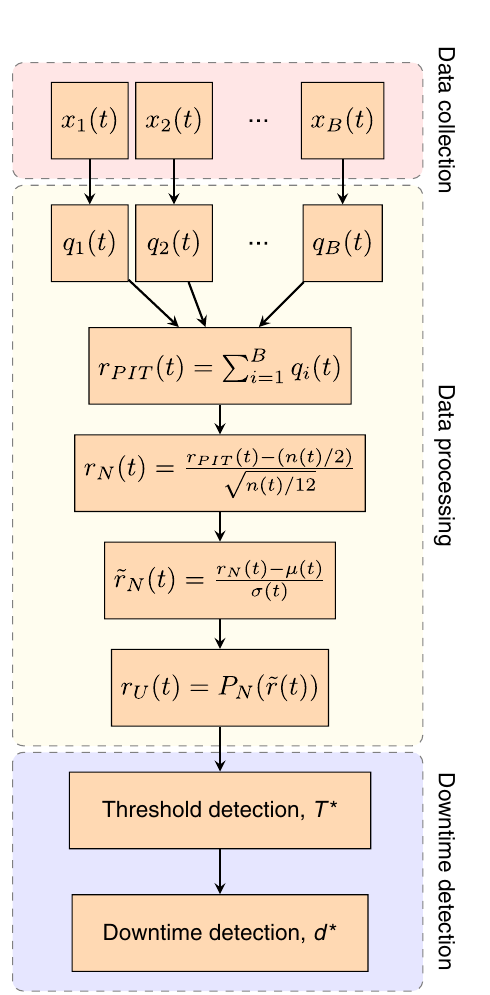
Fig. 2 Schematic for the proposed framework to detect downtime of small businesses after natural hazard events. Data collection: The time series of posting activity x i ð t Þ for each business i is collected. Data processing: The ‘ mid-quantiles' of each series x i ð t Þ are computed to determine transformed individual time series q i ð t Þ for each business i . The aggregate time series r PIT ð t Þ is transformed by a shifting and rescaling to have mean zero and variance one ( ~ r N ð t Þ ). The probability integral transform is then applied to form a fi nal transformed time series r U ð t Þ for the level of activity in the region. Downtime detection: Threshold T (cid:4) is found using the elbow method to identify anomalous events. For a given event, the downtime length, d (cid:4) is